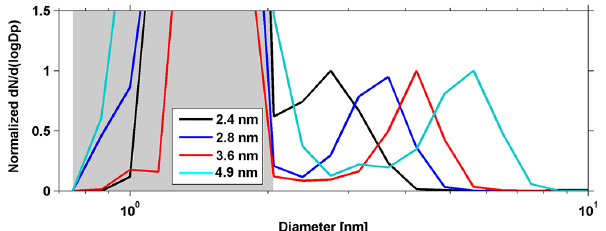
Figure 3. The size distributions of four different sizes of neutral sil- ver particles measured with the NAIS (positive charging, automatic post-filtering). The shaded area represents the size range of corona charger ions.